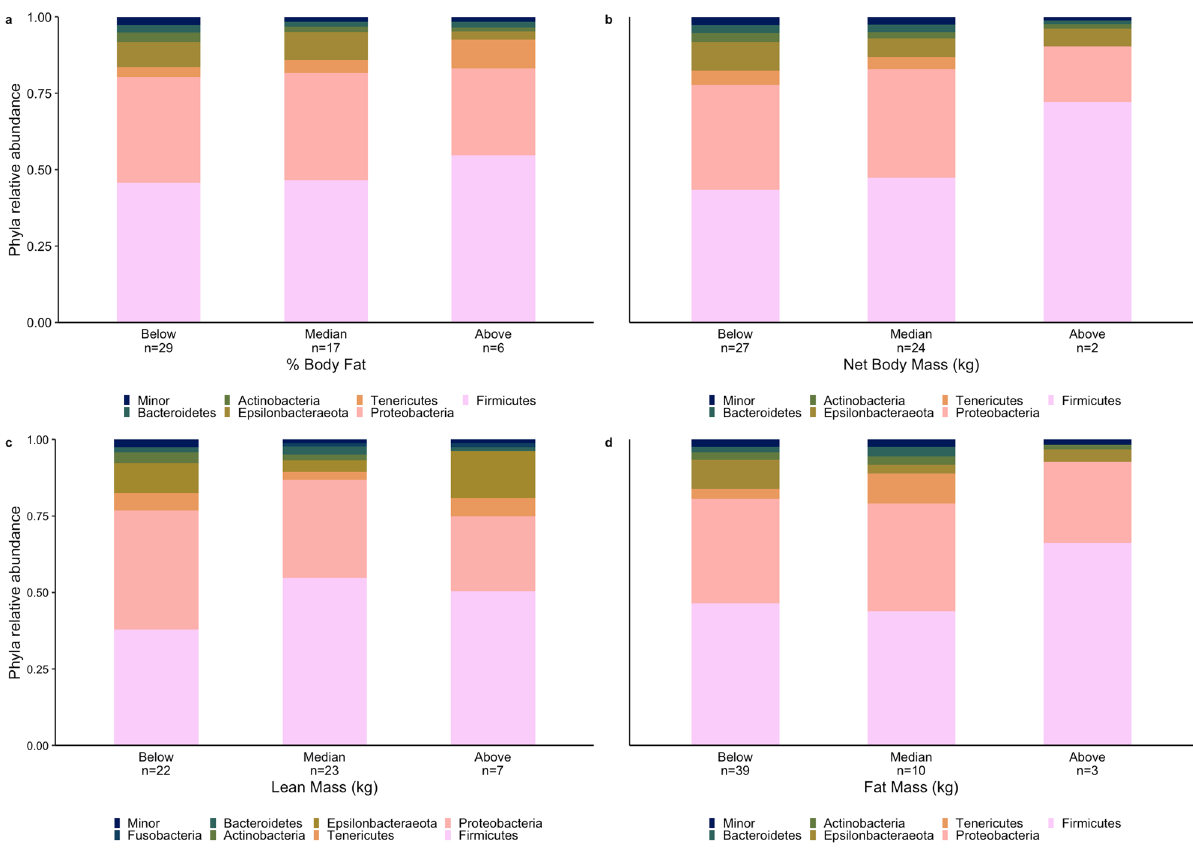
Figure 1. Relative abundance of the major GMB bacterial phyla identified across ( a ) percent body fat; ( b ) net body mass; ( c ) lean mass; and ( d ) fat mass in Alaskan brown bear ( Ursus arctos ). We include all major taxa occurring at ≥ 1% relative abundance; “minor” taxa are those occurring at < 1% relative abundance. Body metrics categories were created using median